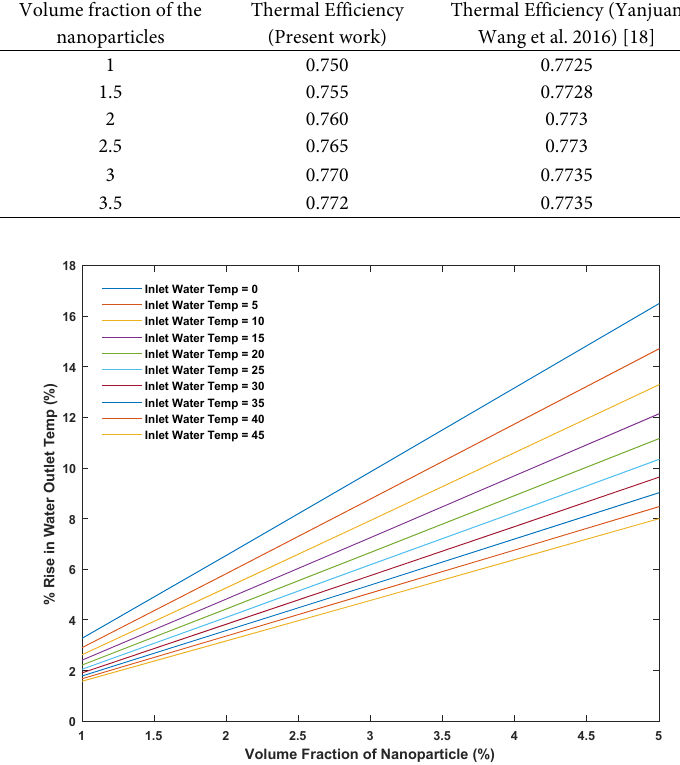
Table 4. Comparison of present work with the previous work Volume fraction of the Thermal Efficiency Thermal Efficiency (Yanjuan nanoparticles (Present work)